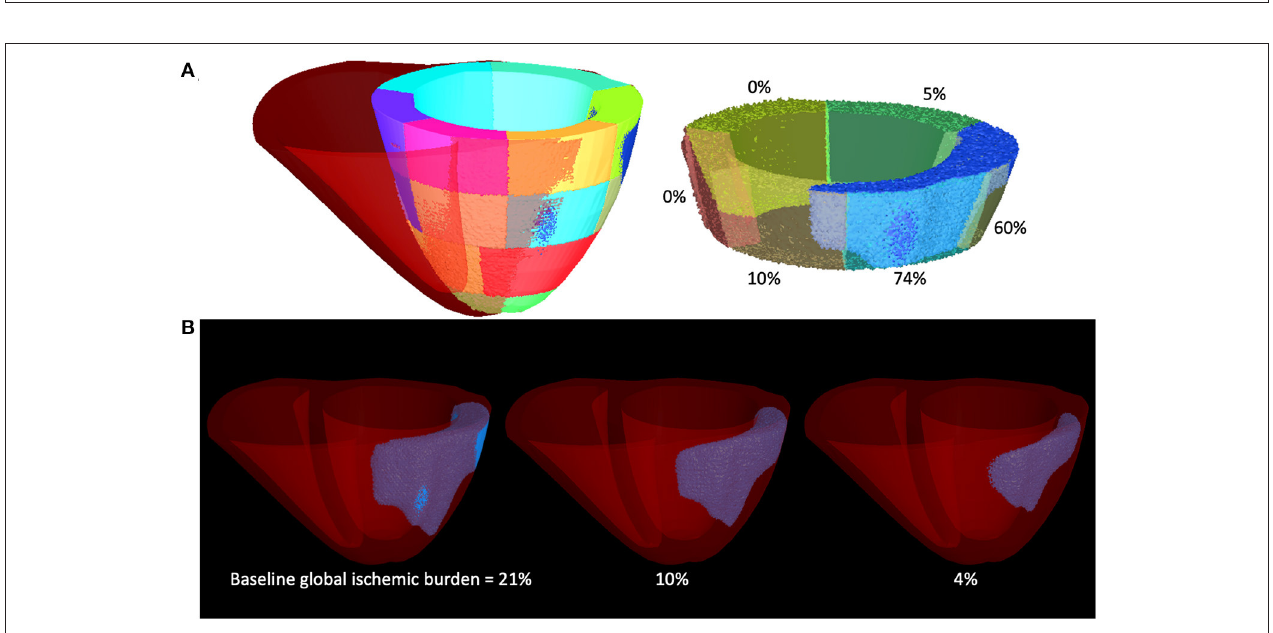
FIGURE 3 | (A) Left to right: 3D representation of an exemplar patient model of the same 17-segment mapping, a medial slice of the same patient heart model showing accompanying percentages of segment-specific ischemic burden. (B) Left to right: the same heart with semi-transparent LV, showing the global ischemic burden in the baseline model, and this global burden reduced to 10 and then 4% to create two additional patient models for the augmented population. Both segment-specific and global myocardial volume and ischemic burdens were used as features for machine learning models in this